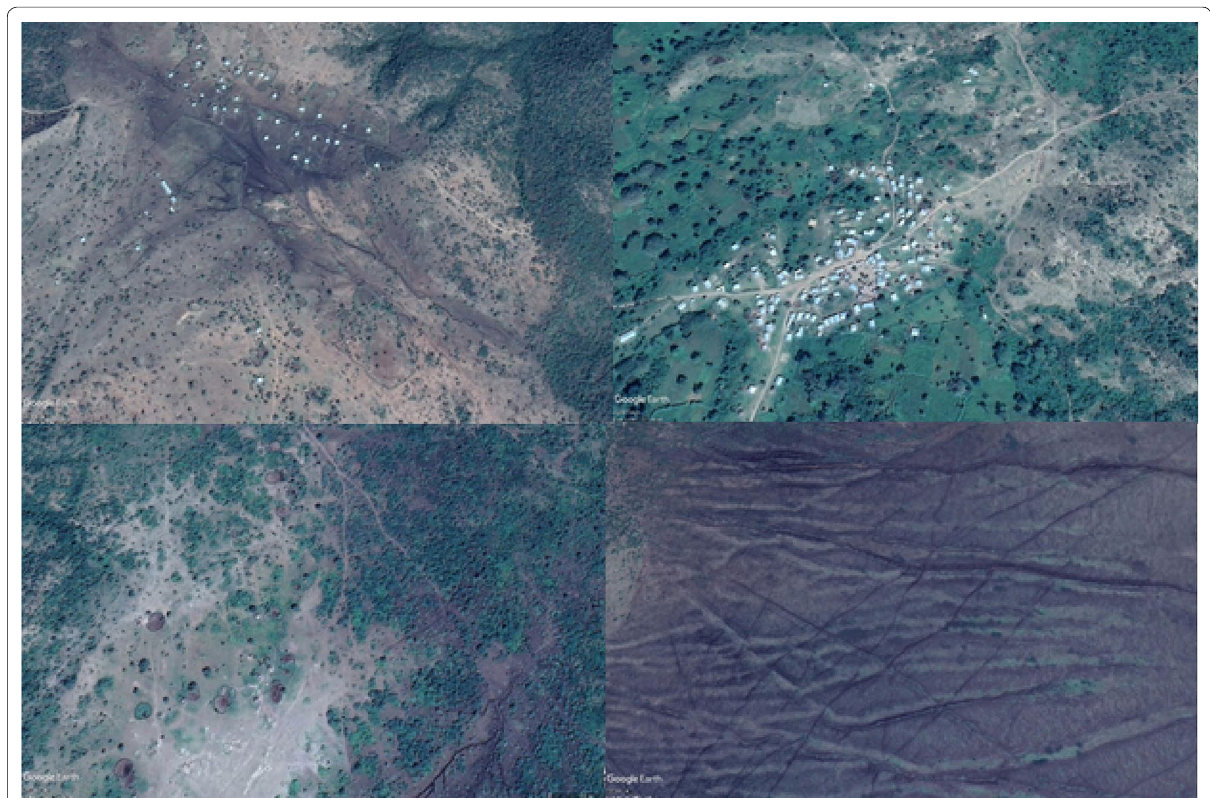
Fig. 5 Anthropogenic disturbances of habitats and associated land degradation at NSNP (Source: Google Earth Digital